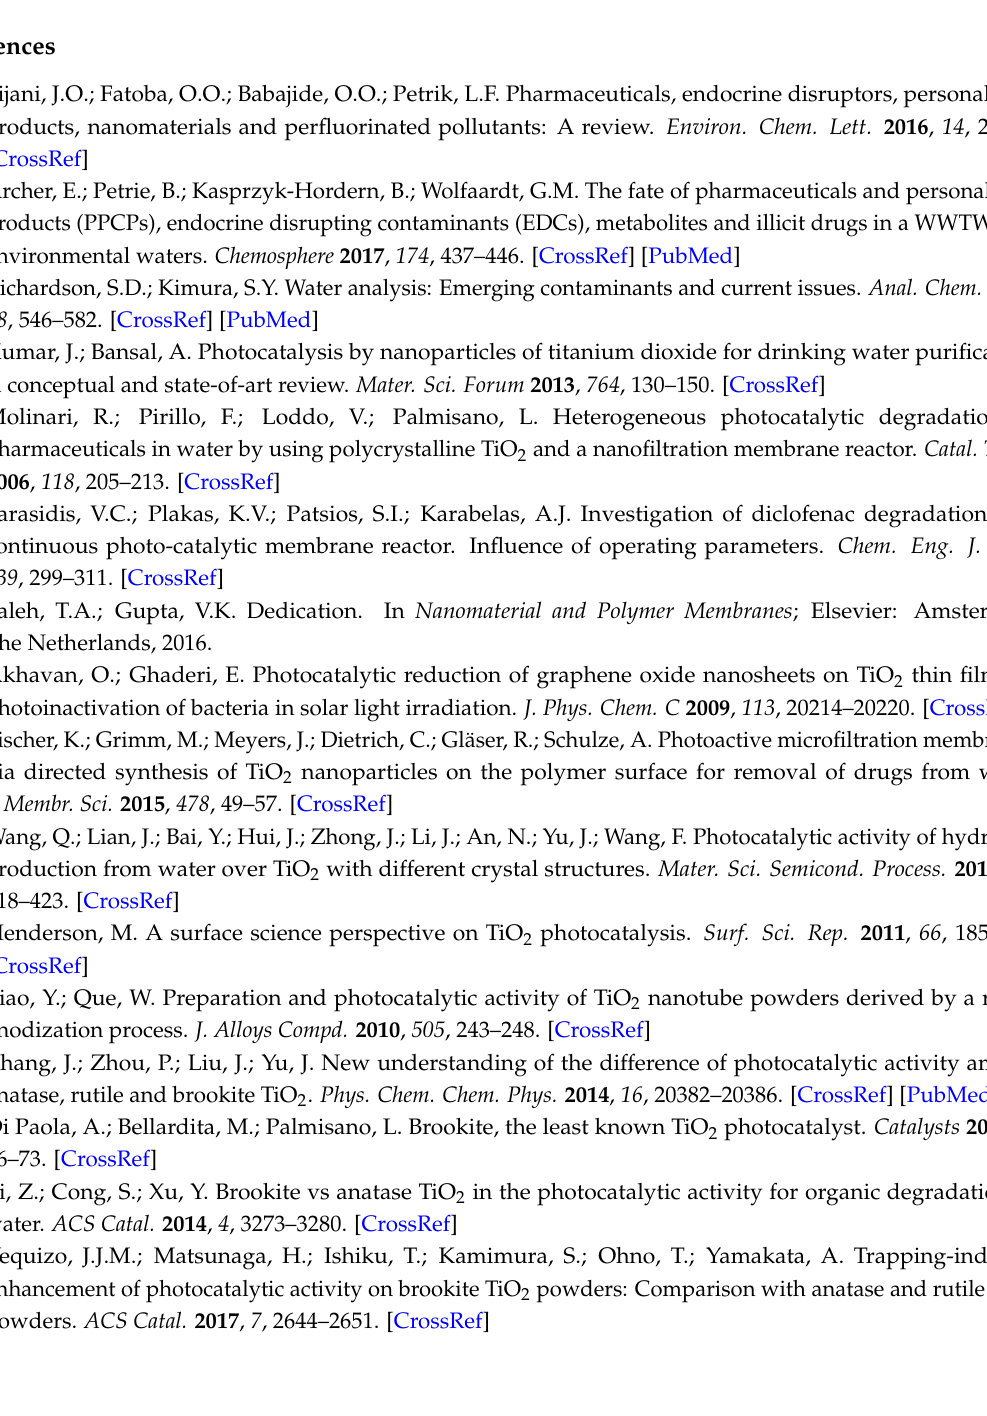
Figure S1. Crystal size of TiO 2 depending on temperature and acid concentration calculated by the Scherrer